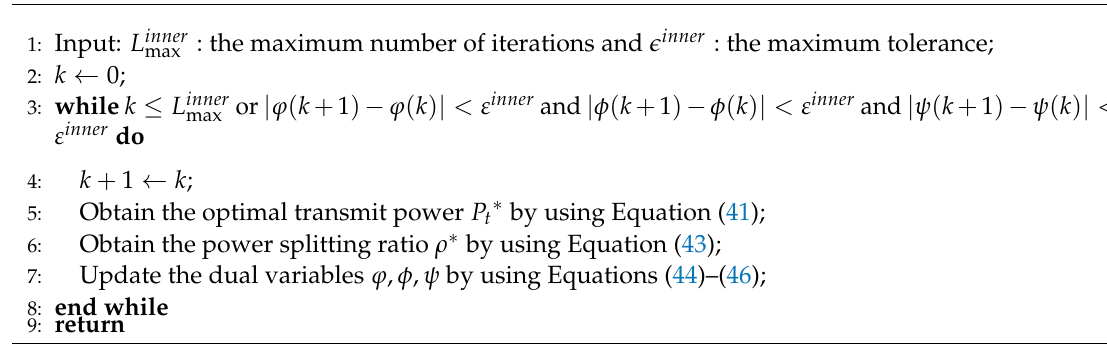
Algorithm 3 Inner Loop Iterative Algorithm for obtaining P t ∗ and ρ ∗ for given η PS